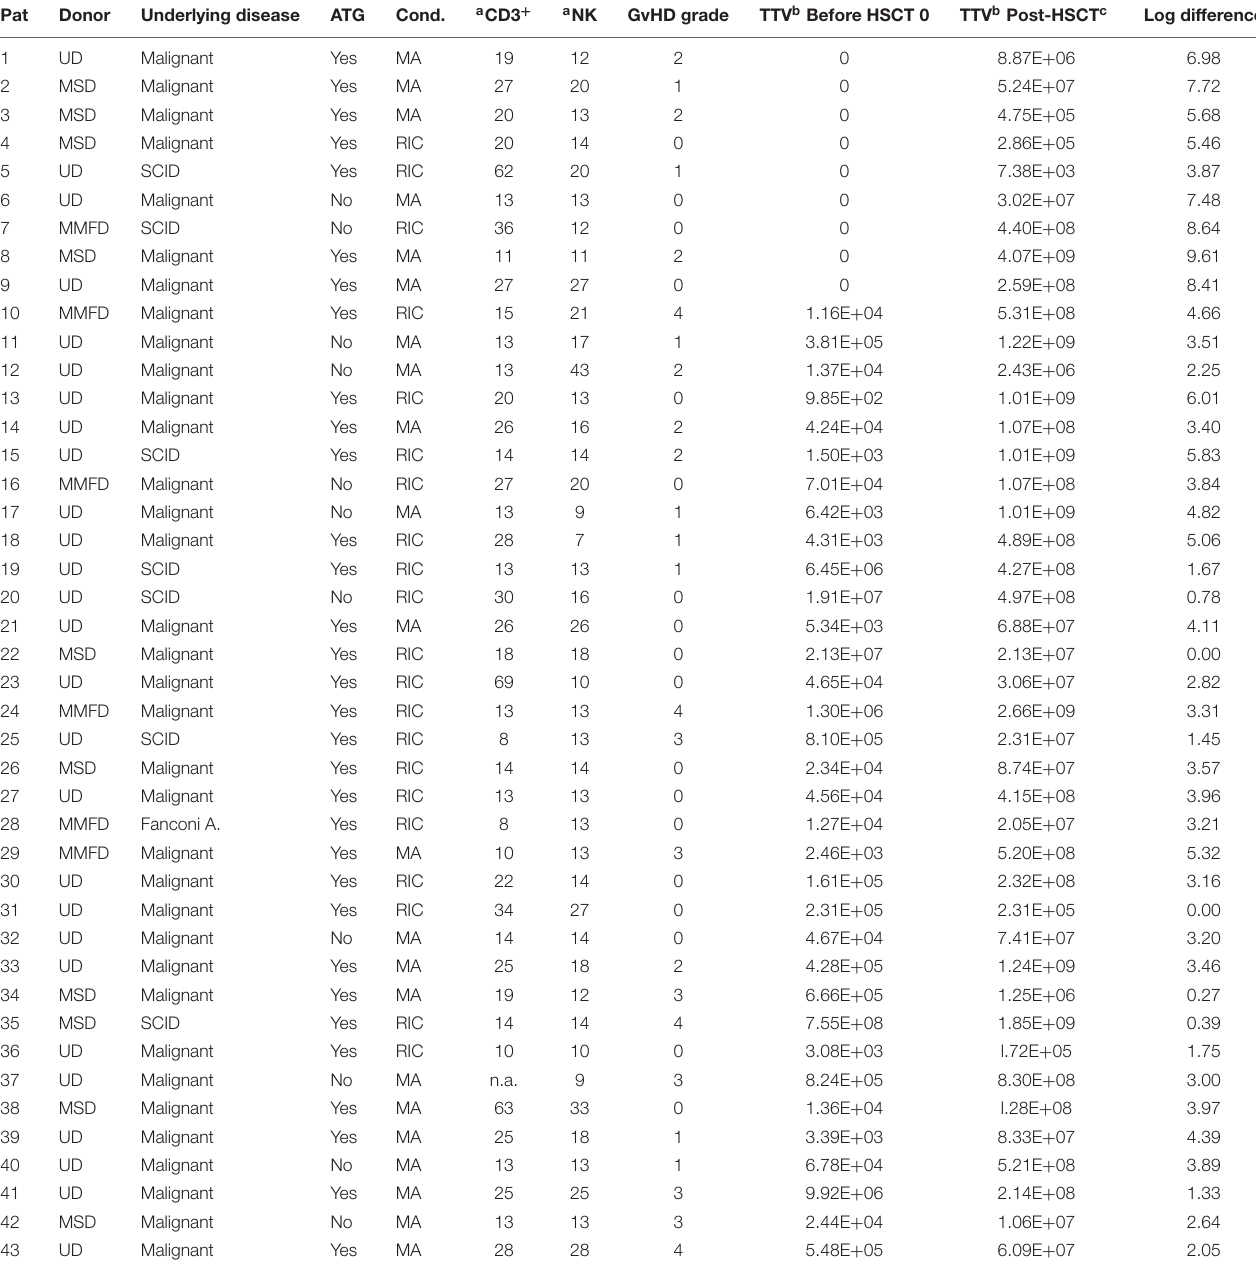
TABLE 1 | Characteristics of the HSCT recipients investigated and TTV copies/ml plasma.